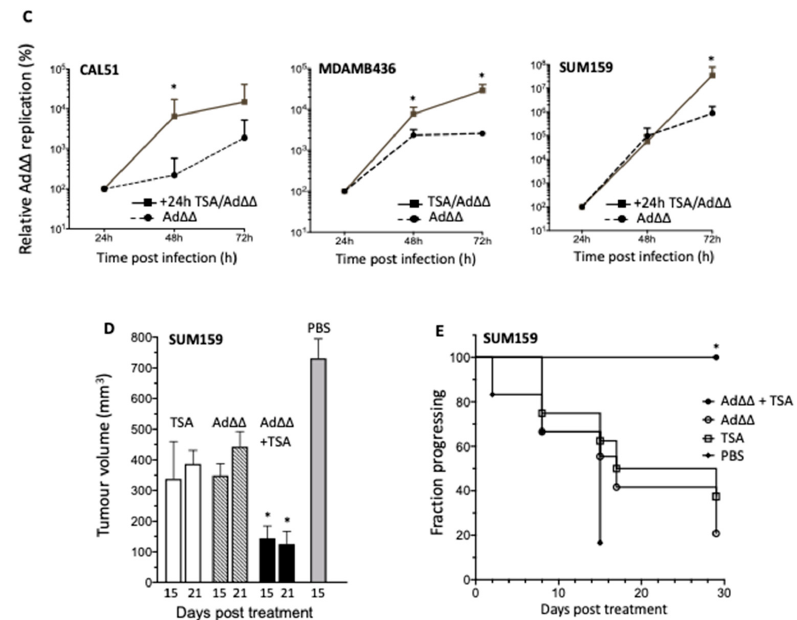
Figure 2. Efficient Ad ∆∆ replication in PDAC cells and TNBC cells and in vivo efficacy in SUM159 tumour xenografts. ( A ) PDAC cells were infected with Ad ∆∆ at 100 ppc and treated with 0.25 μ M or 0.5 μ M TSA. Left panel: TSA was added simultaneously with infection. Right panel: TSA was added 24 h prior to infection, ** p < 0.002. ( B ) TNBC cells were infected with Ad ∆∆ at 100 ppc and 0.25 μ M TSA was added; cells and medium were harvested 48 h after infection. Left panel: TSA was added 24 h after infection (+24 h TSA) and compared to cells treated simultaneously (TSA) or without TSA (0). Right panel: TSA was added 24 h before infection ( − 24 h TSA), and compared to cells treated simultaneously (TSA) or without TSA (0), p > 0.05. ( C ) Relative Ad ∆∆ (100 ppc) replication rates over time when TSA was added under optimal conditions in each cell line. CAL51 and SUM159; TSA added 24 h after infection, MDAMB436; TSA added simultaneously with virus. Infectious units (pfu/mL) were determined by TCID50 assays and expressed as percentages of the respective treatment at 24 h. ( A – C ) Data expressed as averages ± SD, * p < 0.05, ** p < 0.002, n = 2. ( D , E ) SUM159 xenografts in athymic mice treated with Ad ∆∆ at 1 × 10 10 vp on day 1, 3 and 7 intratumourally or 1.5 μ g TSA/g on day 2, 4 and 8 intraperitoneally, or combined treatment with Ad ∆∆ + TSA at the same dose schedule. Tumour volumes shown for day 15 and 21 after last day of treatment ( D ) and time to progression ( E ) (<500 mm 3 ; * p < 0.05 (Ad ∆∆ + TSA vs. Ad ∆∆ and TSA alone), 6 animals/group.